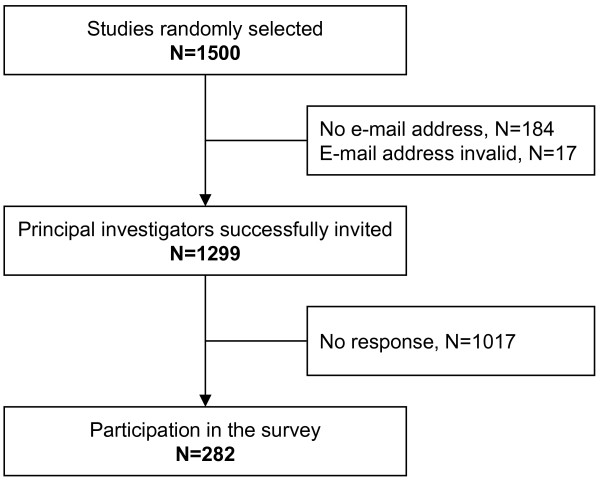
Study flow diagram.